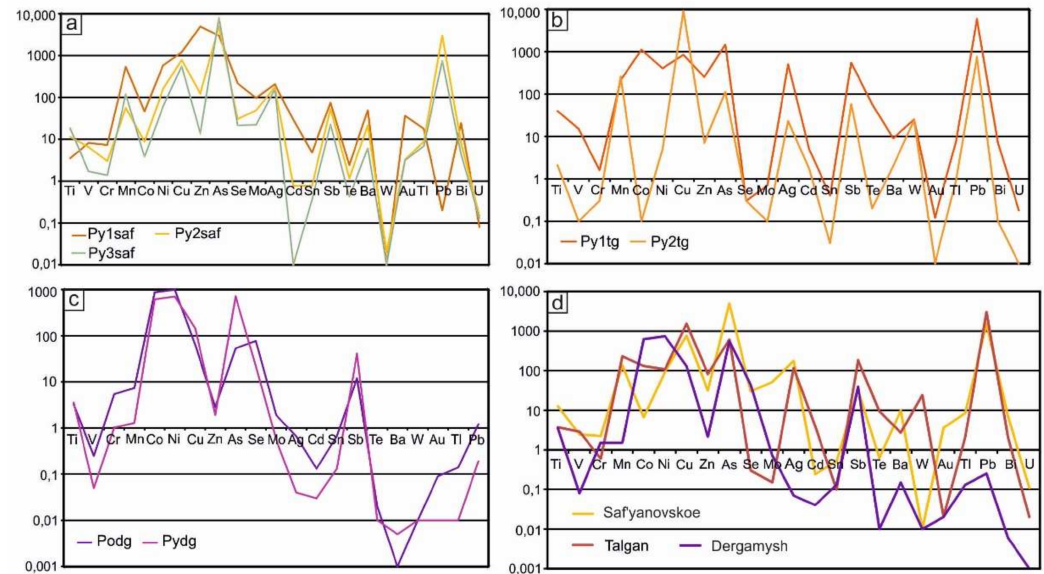
Figure 10. Comparative log–log plots for median trace element composition of individual zones of sulfide nodulesfromsulfide–blackshalediagenitesoftheSaf’yanovskoedeposit( a ), sulfide–carbonate–hyaloclastite diagenites of the Talgan deposit ( b ), sulfide–serpentinite diagenites of the Dergamysh deposit ( c ), and their general trace element composition including all zones of each nodule ( d